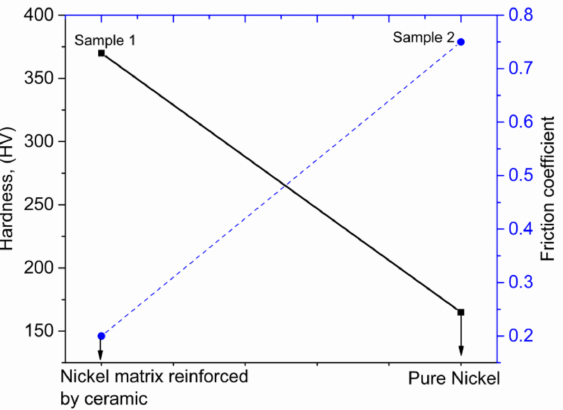
Figure 10. Hardness and friction coefficient of Nickel (Ni) matrix reinforced by ceramics (NCMMCs); based on the data from [95].